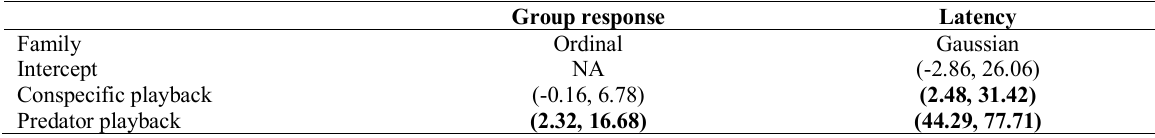
95% Confidence Interval Results for Effects of Playback Stimuli on Group Response and Latency